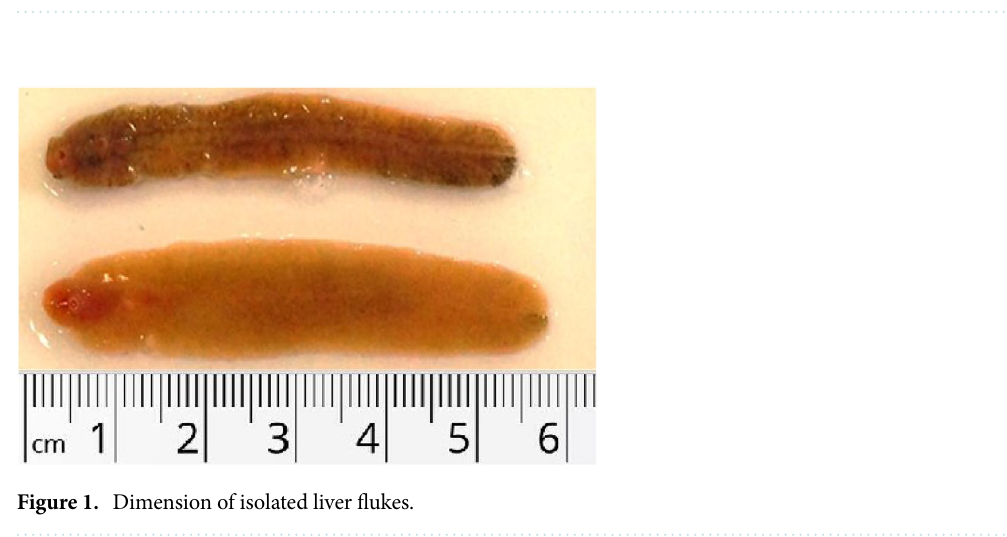
Table 1. The number and rate of infection of local and imported sheep. p1, comparison between local and imported sheep during each month; p2, comparison between local infected and non-infected sheep; p3, comparison between imported infected and non-infected sheep; p4, comparison between imported and local infected sheep among all seasons.